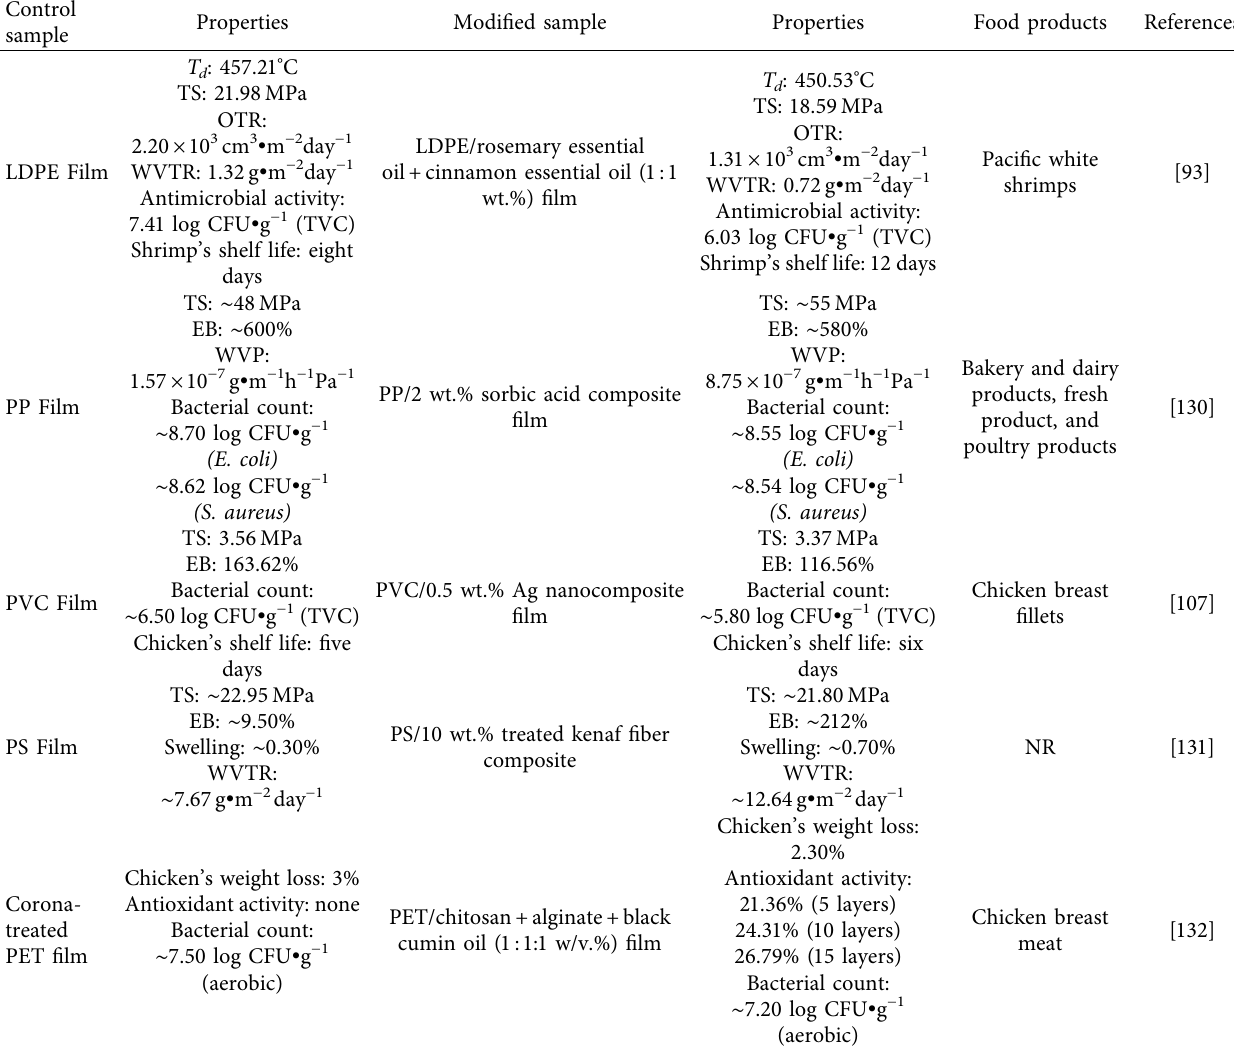
Table 2: Nonbiodegradable composite-based food